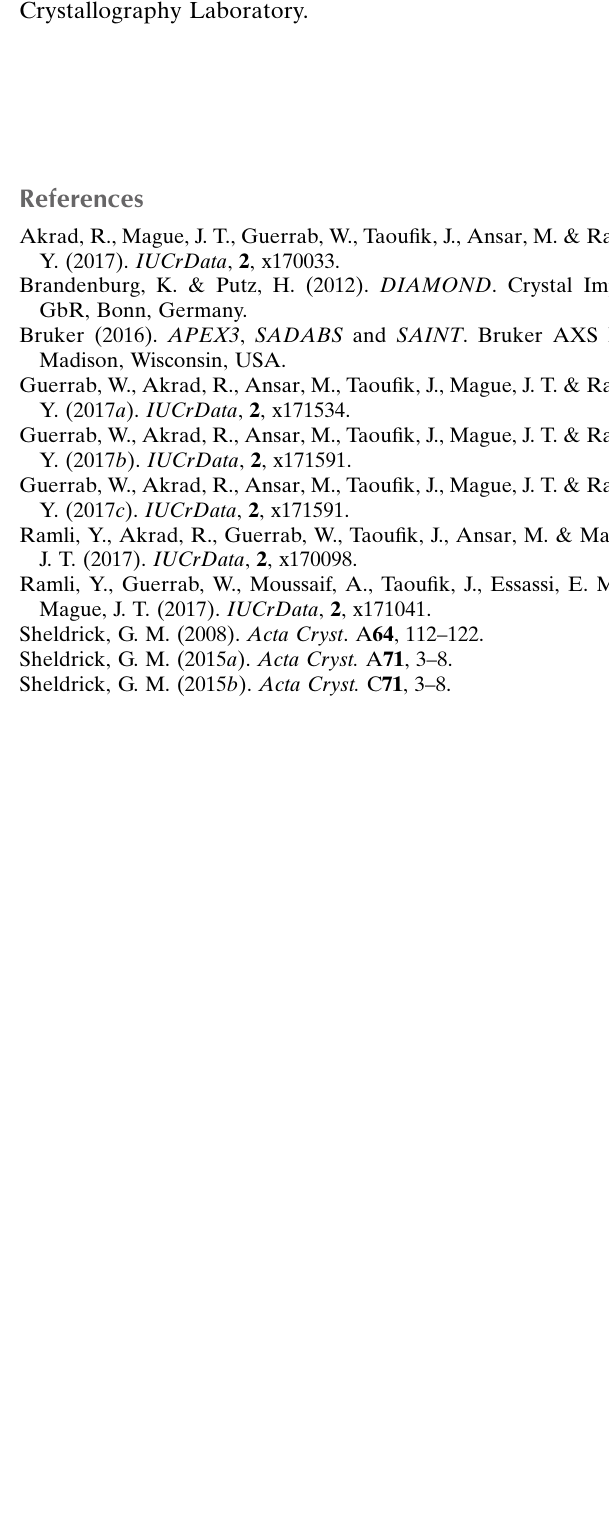
Table 2 Experimental details. Crystal data Chemical